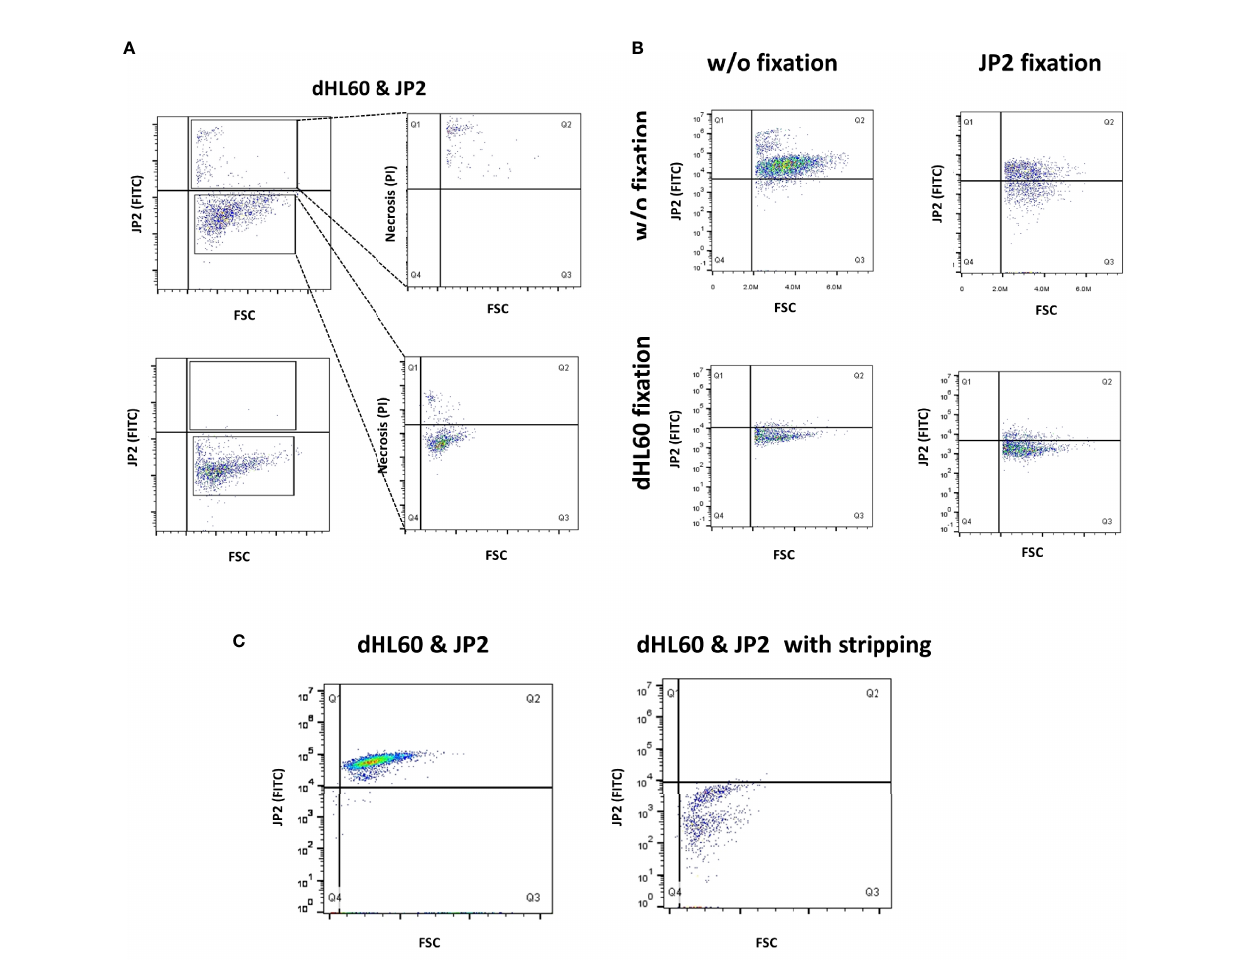
FIGURE 4 | Interaction between JP2 and HL-60 cells. Differentiated HL-60 cells were infected with the JP2 clone of A. actinomycetencoomitans (JP2) for analysis of the interaction between the cells and the bacteria. Gating strategy is displayed in Supplementary Figure 3 . (A) The site of JP2 adherence to neutrophils was examined by staining JP2 with fl uorescein isothiocyanate (FITC), followed by quenching of the extracellular FITC staining with trypan blue, and analysis with fl ow cytometry. the top plot show analysis without quenching; the bottom plot show analysis with quenching. (B) Examination of JP2 adherence to neutrophils by denaturation of protein (paraformaldehyde fi xation) and the use of fl uorescein isothiocyanate (FITC)- tagged JP2. (C) Examination of JP2 adherence to neutrophils following incubation with stripping protein and the use of fl uorescein isothiocyanate (FITC)-tagged